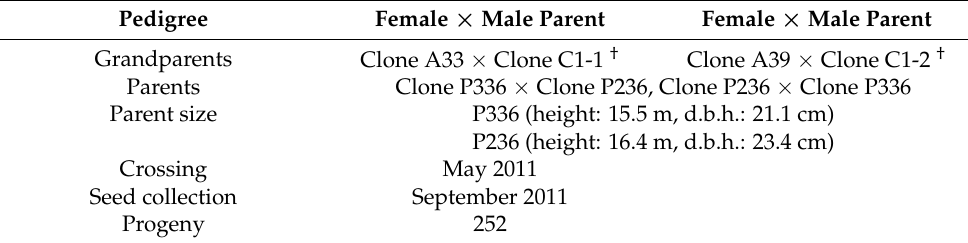
Table 1. The Sakhalin fir segregated population used for QTL analysis. Grandmother parent Clones (A33 and A39) are mother trees inhabiting high-altitude zones (1200 m). Clone 1-1 and Clone 1-2 are low-altitude genotypes derived from a pollen mixture collected from three genotypes living at low-altitudes (530